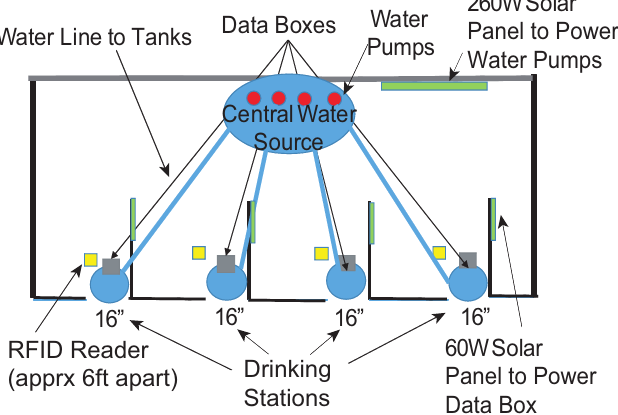
Figure 4. Drinking station deployed in the testing